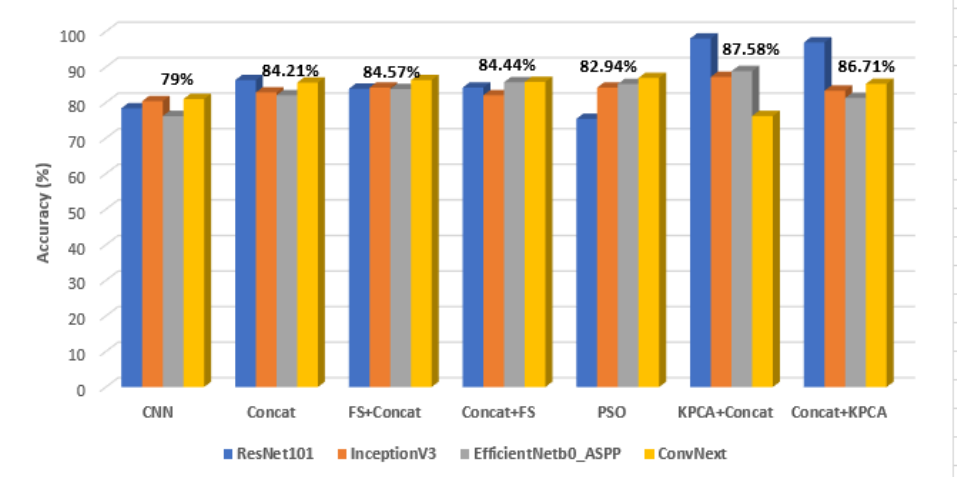
Figure 5. The comparisons between the average accuracy values obtained for each combination scheme for the considered CNN architectures in the case of the GE9